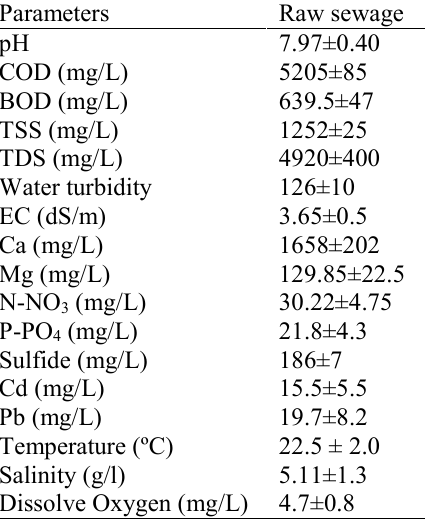
Table 2. Physicochemical properties of municipal